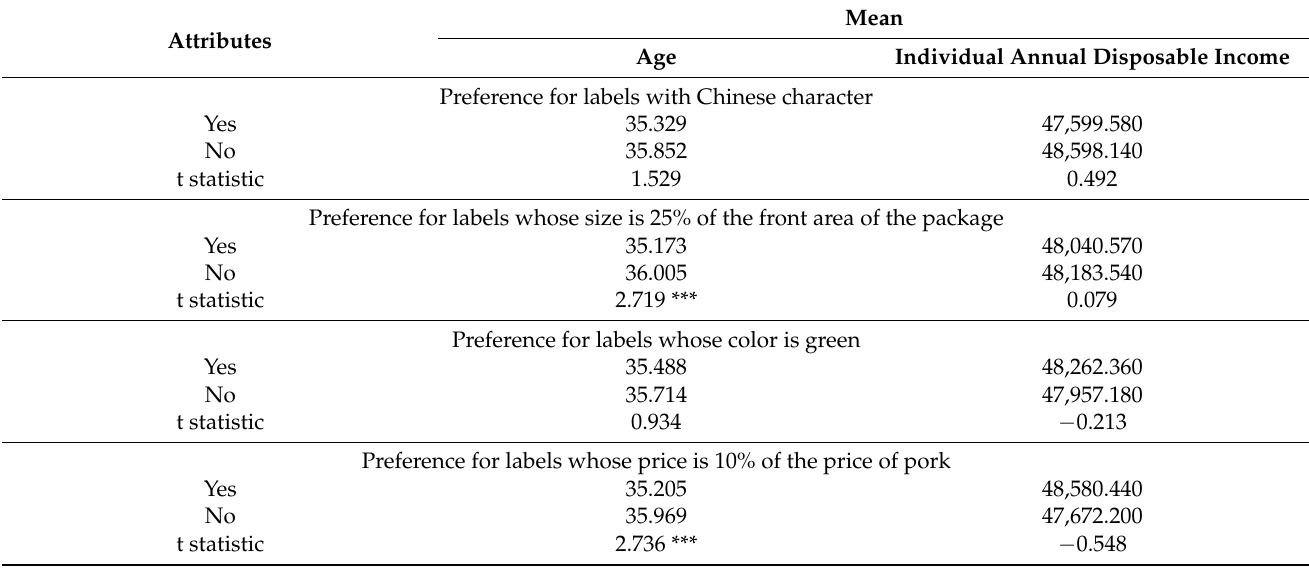
Table 6. Preference for labels’ attributes by consumers with different characteristics (continuous variables).